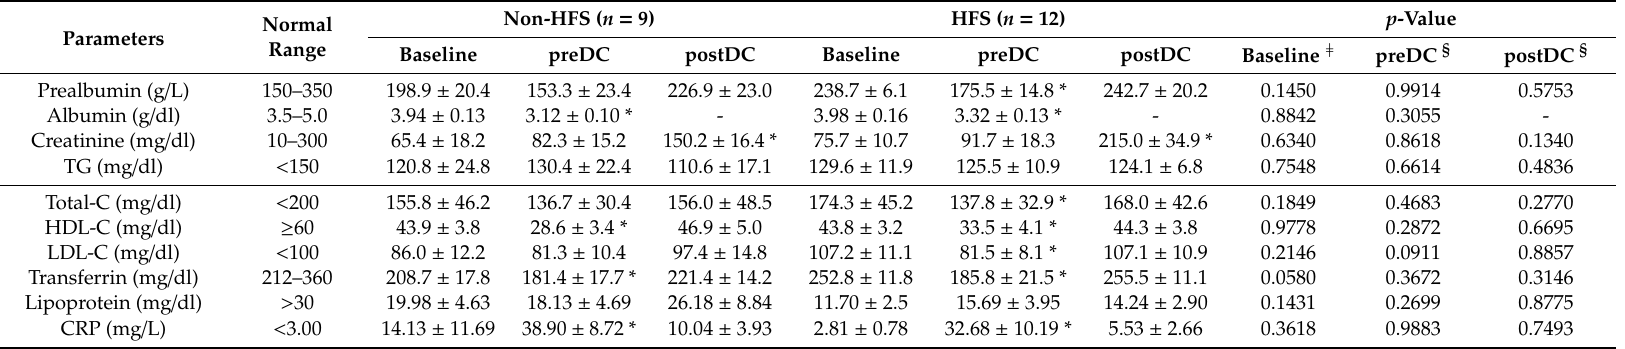
Table 2. Comparison of biochemical parameters between non-HFS and HFS